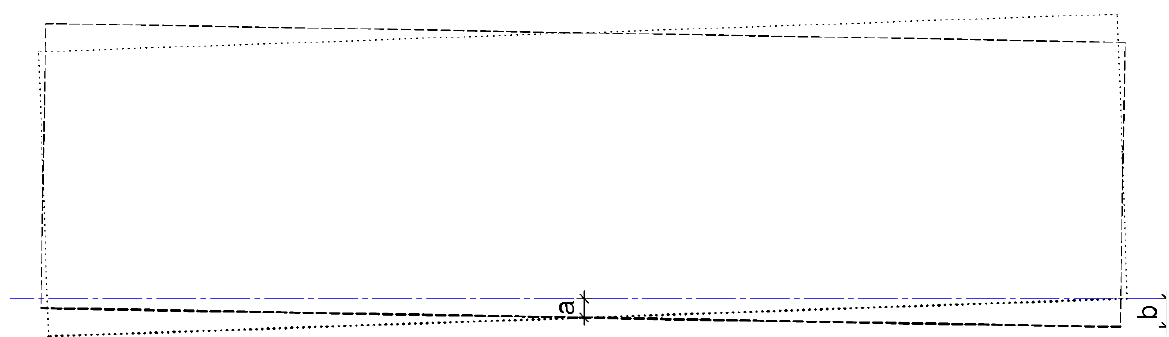
Fig. 10 Schematic illustration of a laminated glass with twisted individual glass